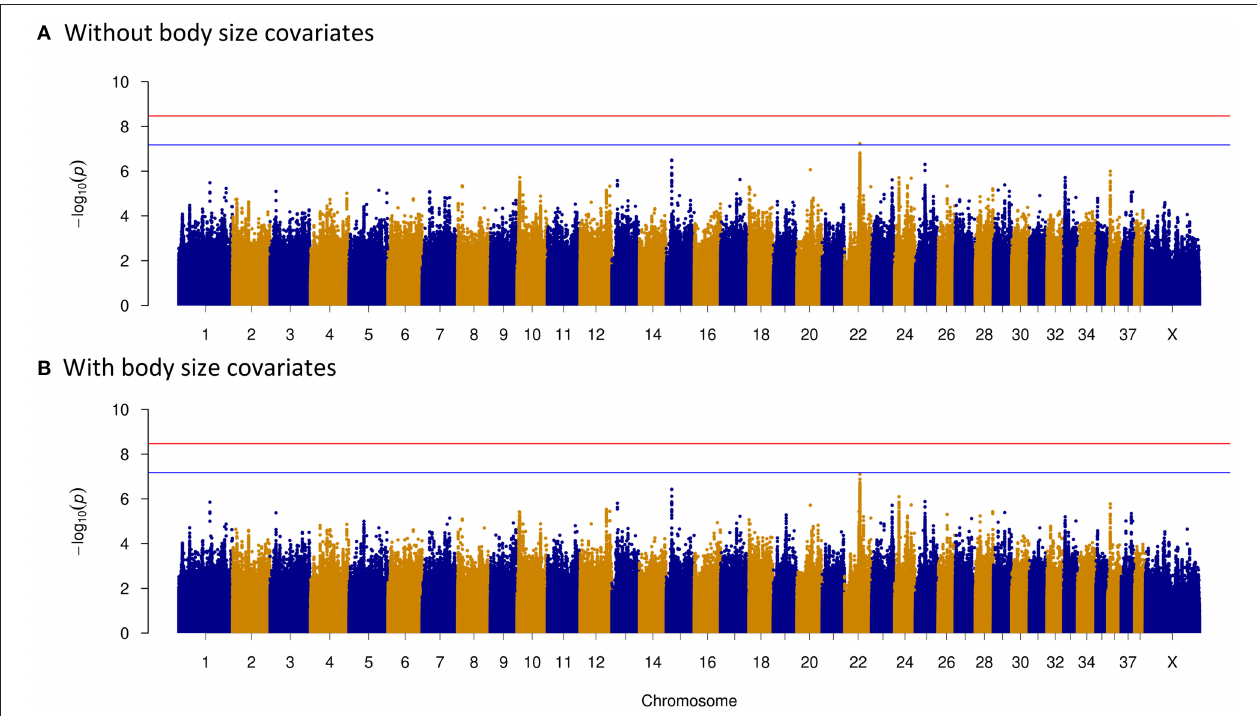
FIGURE 5 | One variant is above the suggestive threshold of dog trainability genome-wide association study (GWAS). Manhattan plots showing the association of whole genome variants with trainability levels in dogs. Bonferroni and suggestive thresholds are indicated with red and blue lines. (A) Without including body size as a covariate. One variant on CFA15 slightly passed the suggestive threshold. (B) Including body size as a covariate. No variants were detected above the suggestive threshold.